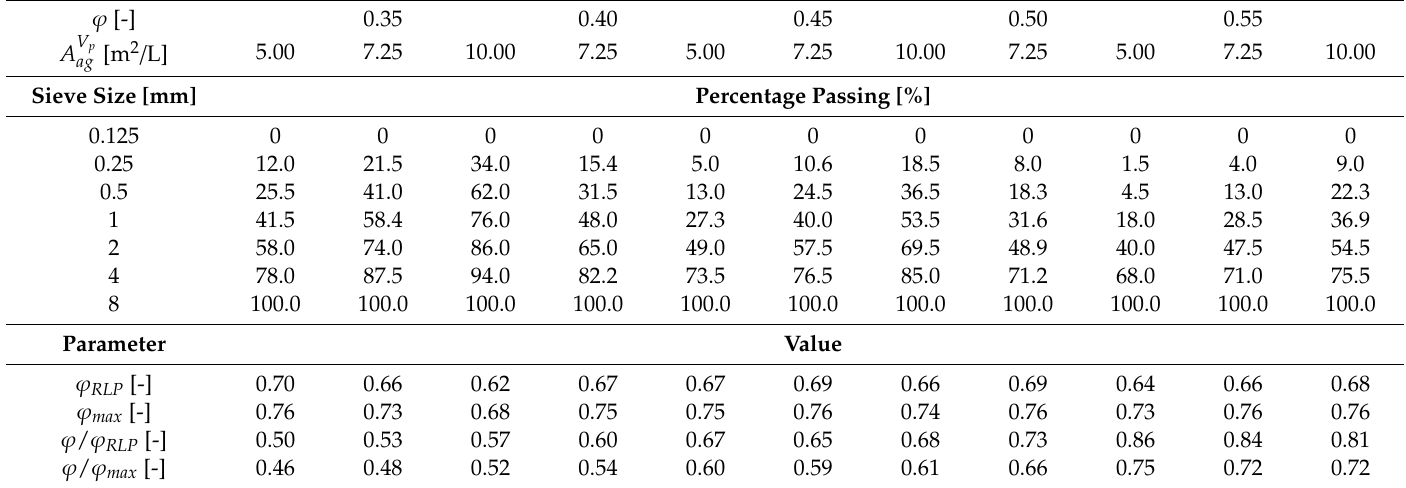
Table 1. Grading curves of the aggregate compositions.